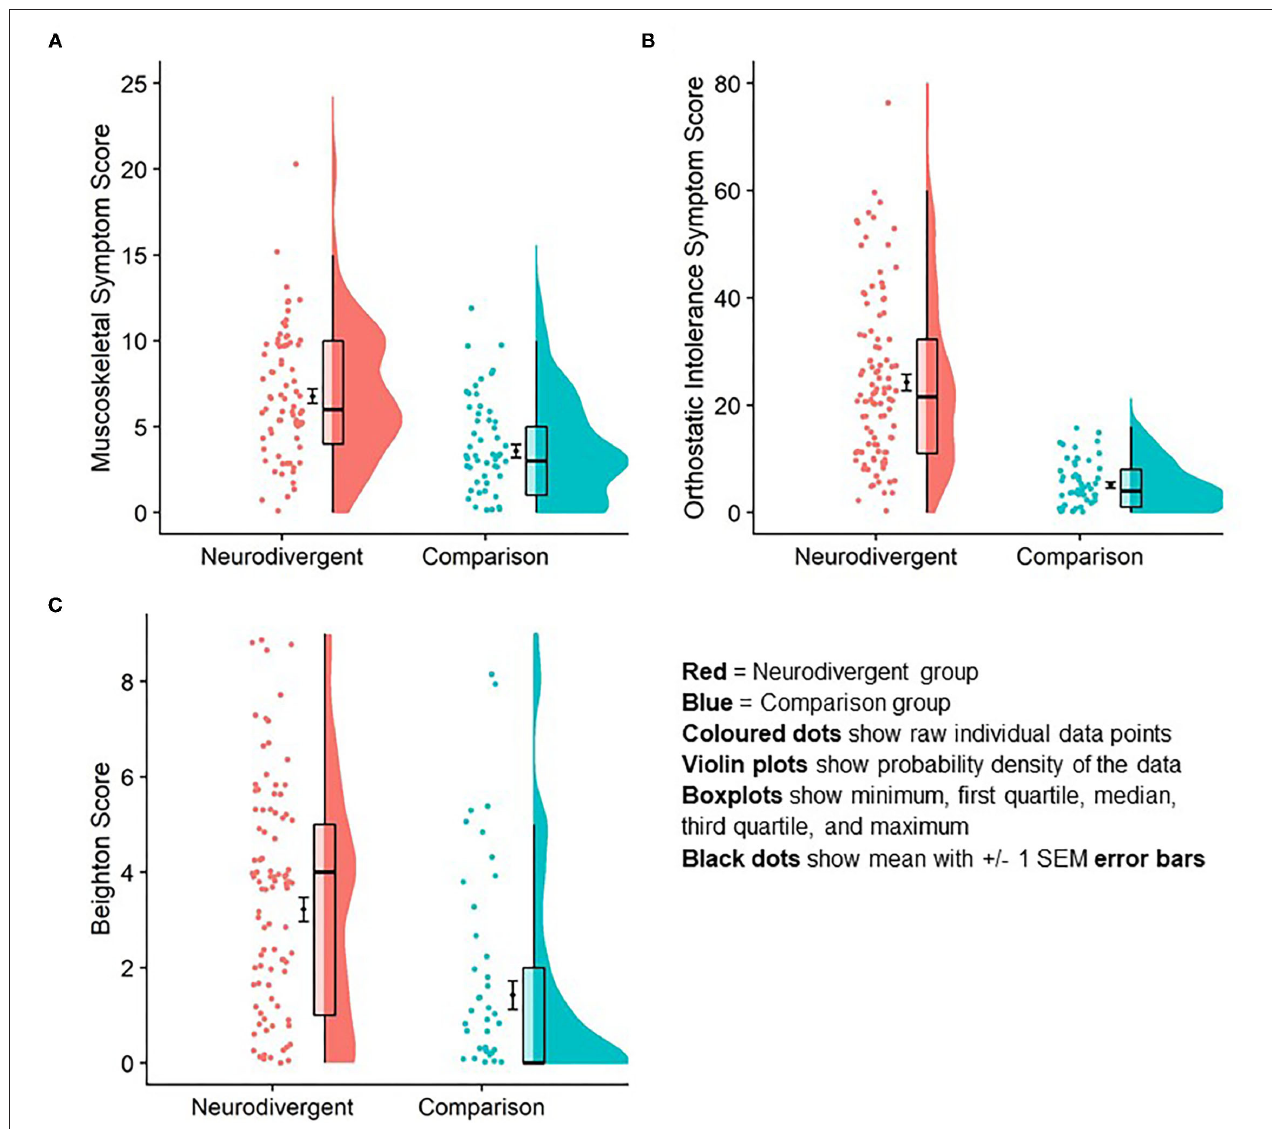
FIGURE 3 | Difference in orthostatic intolerance symptom score (A) ; musculoskeletal symptom score (B) and Beighton score (C) between neurodivergent and comparison group. Graphic is a data rain cloud illustrating raw data, median and interquartile range, and probability density for each variable in each group. Mean and standard error are visualized